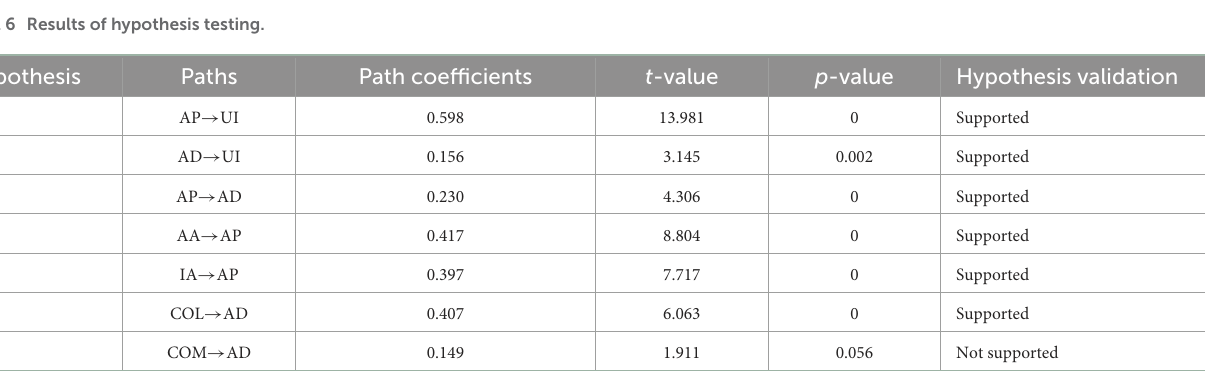
TABLE 6 Results of hypothesis